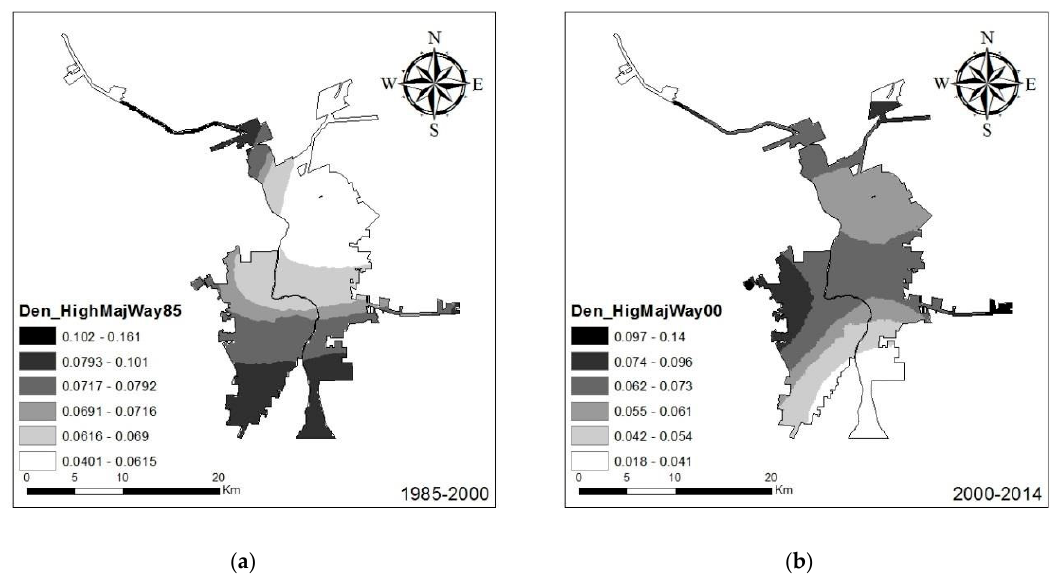
Figure 10. Logistic GWR results: estimated coefficient of density of the highway and major roads, 1985–2000 ( a ) and 2000–2014 ( b ).